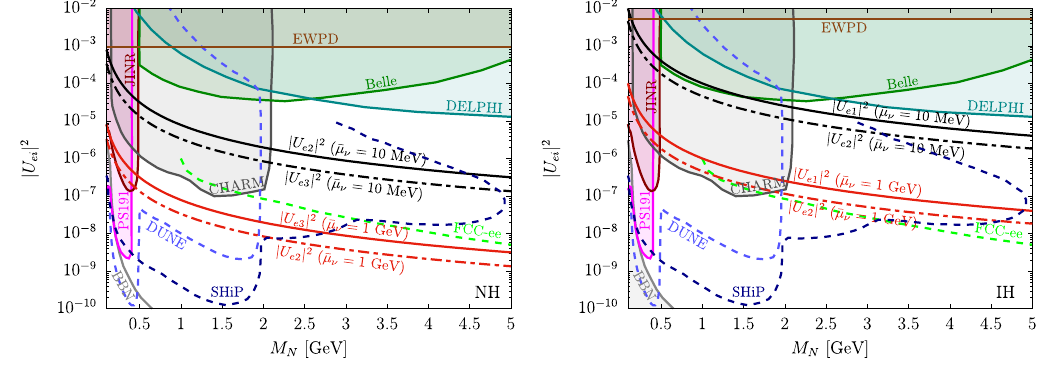
Figure 2 . Summary of constraints on HNL mixing with electron neutrinos, over mass range of interest for our model (left: normal hierarchy, right: inverted hierarchy). Solid and dot-dashed black and red curves show the model’s predictions for U in the normal (inverted) mass hierarchy, for two choices of the parameter (cid:22) (cid:22) mixing through eqs. (4.2), (4.4). U